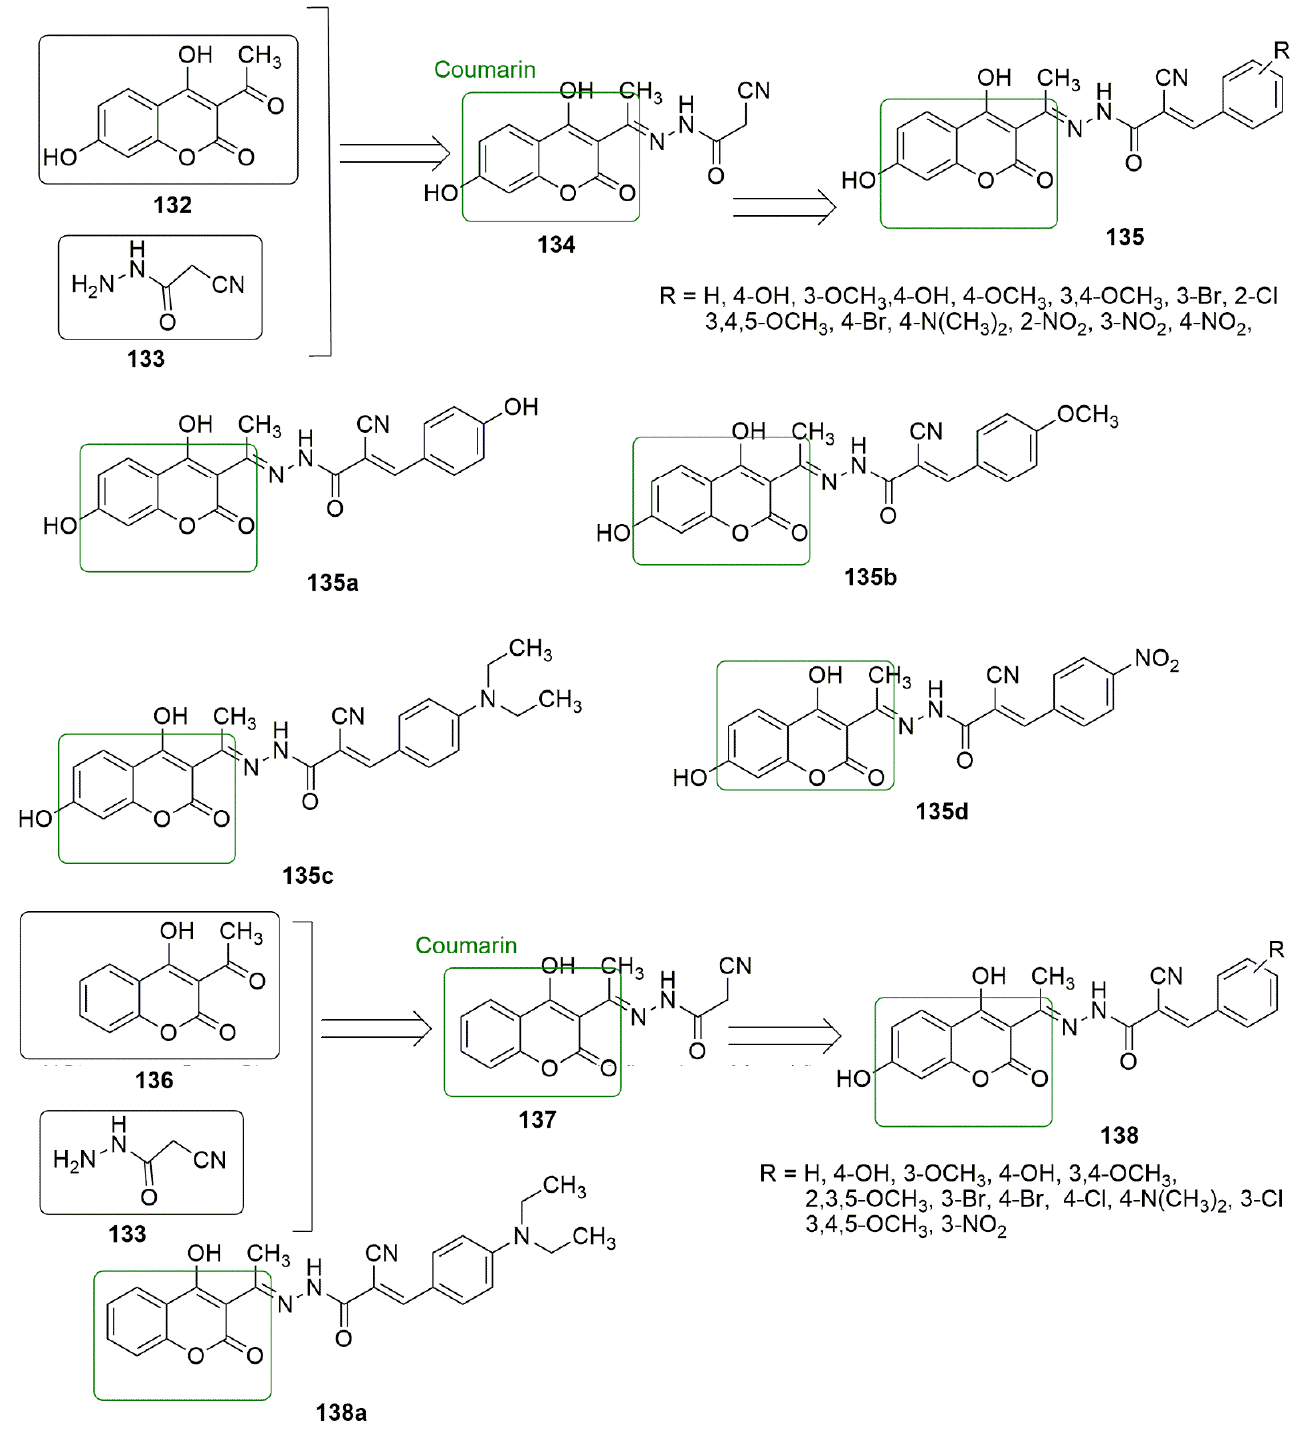
Figure 37. Novel coumarin-based acryloylcyanohydrazone compounds evaluated against a different panel of cancer cell lines.